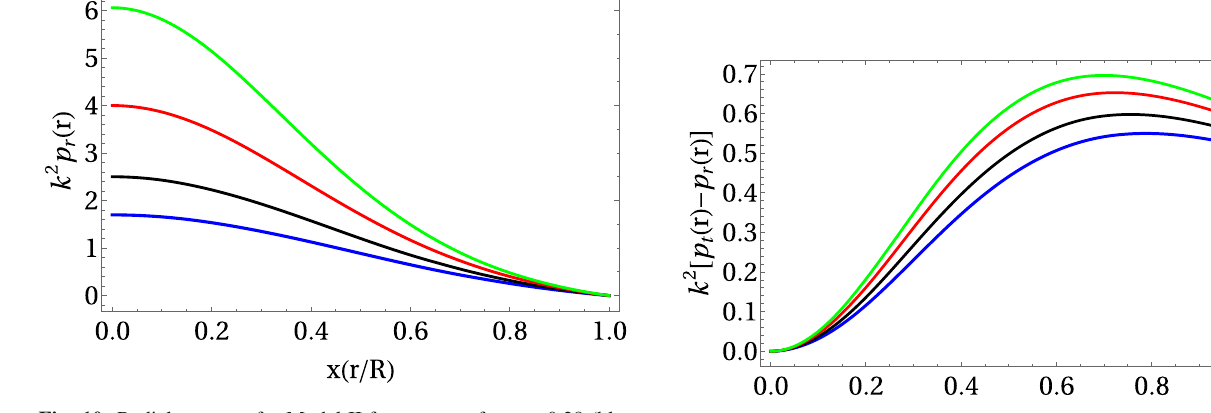
Fig. 10 Radial pressure for Model II for compact factors: 0.38 (blue line), 0.39 (black line), 0.40 (red line) and 0.407 (green line) center of star and decrease monotonously toward the surface.